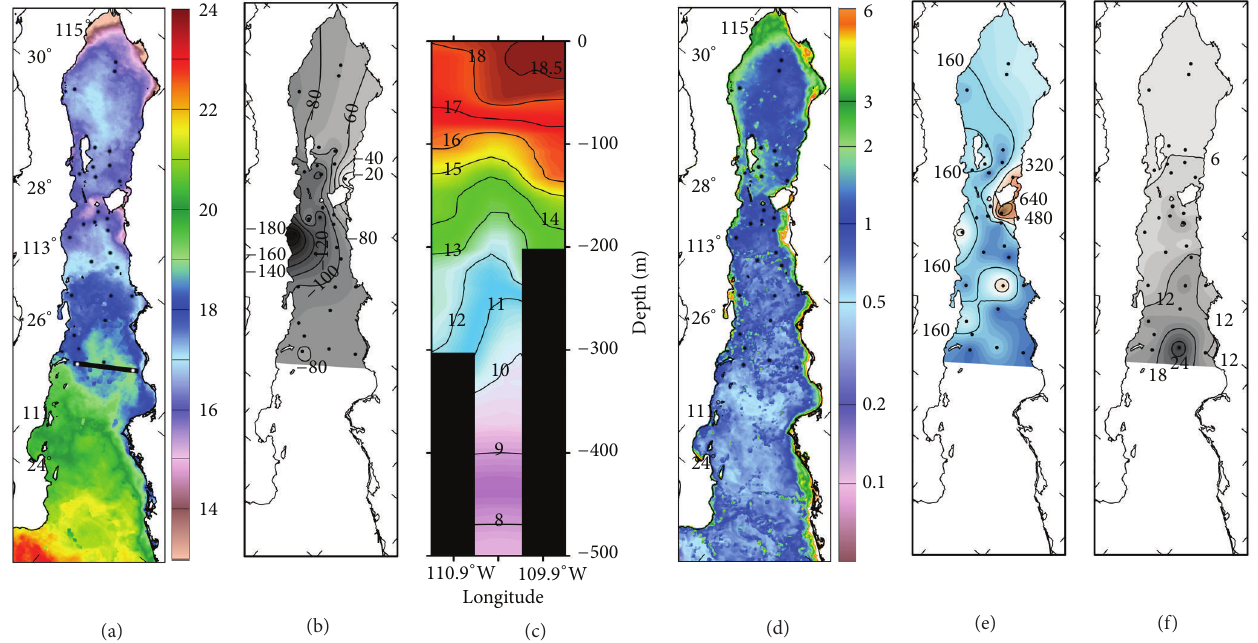
Figure 2: Biophysical characteristics during January. Composite of (a) SST ( ∘ C) and (d) CHL (mg m −3 ) satellite images of the Gulf of California. Black line in (a) indicates transect analyzed for water column profile. (c) Temperature profile ( ∘ C). Distribution of (b) maximum stability depth (MSD), (e) zooplankton volumes, and (f) species richness.